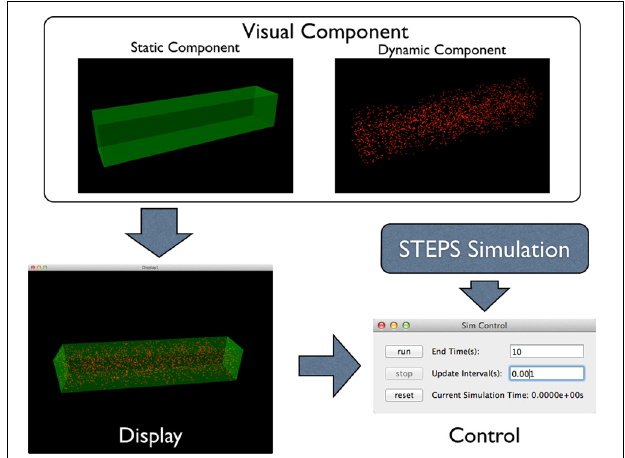
FIGURE 2 | Component Assembly strategy for the visualization toolkit. Visual components, including static and dynamic component, are assembled in a display. The display is then assigned to a simulation control together with the visualized